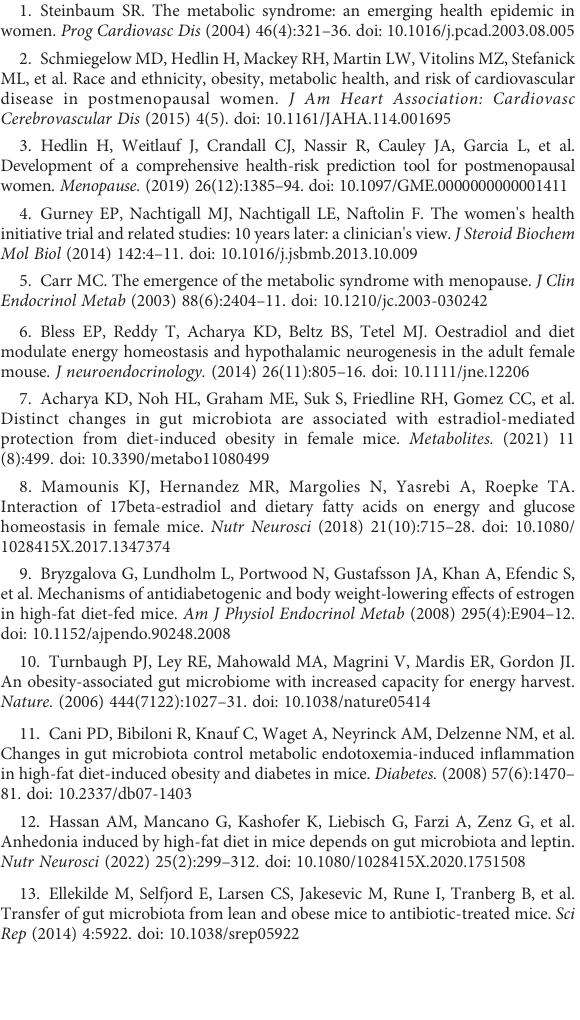
SUPPLEMENTARY FIGURE 1 Hourly measuresof (A) foodintakeand (B) physicalactivityinHFD-fedadult female mice in metabolic cages on days 18 – 21. E-E, E2-treated mice receiving FMT from E2 mice (n=4); V-V, mice with Veh implants receiving FMTfromVehmice(n=4);V-E A ,micewithVehimplantsreceivingFMTfrom E2-treated mice supplemented with A. muciniphila (n=4). SUPPLEMENTARY FIGURE 2 Con fi rmation of Akkermansia in fecal microbiota transplant (FMT) gavage samples. (A) Microbiota taxa relative abundance at genus level in FMT samples, pooled from all donors of the same treatment group (E2 donors n=8; Veh donors n=4). (B) Principal component plot showing weighted Unifrac distance for the FMT samples. E-FMT: FMT from E2-treated donors; V-FMT: FMT from Veh